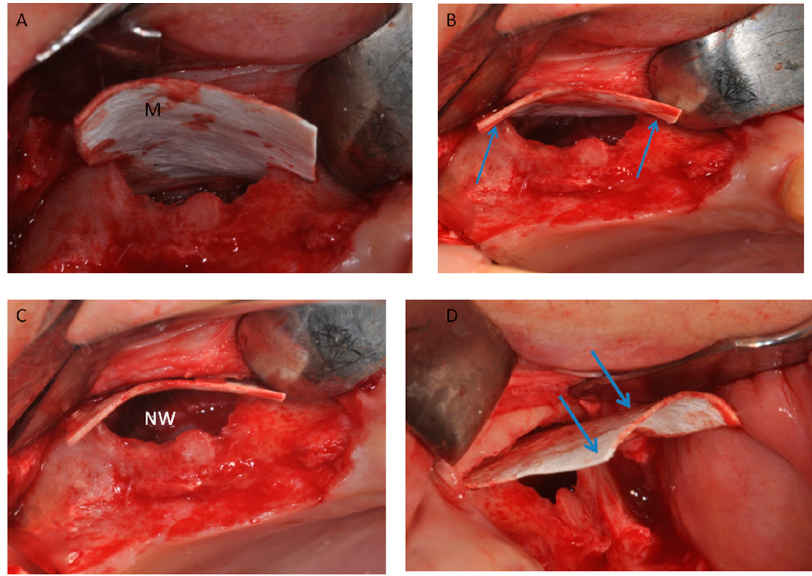
Figure 10. ( A ) Half of the heterologous membrane was positioned on on the top of wall. ( B ) The lamina was adapted on the two lines (Arrows); and ( C ) pushed to the nose wall of the sinus (NW). ( D ) Half of the heterologous membranes external of the sinus (arrows).